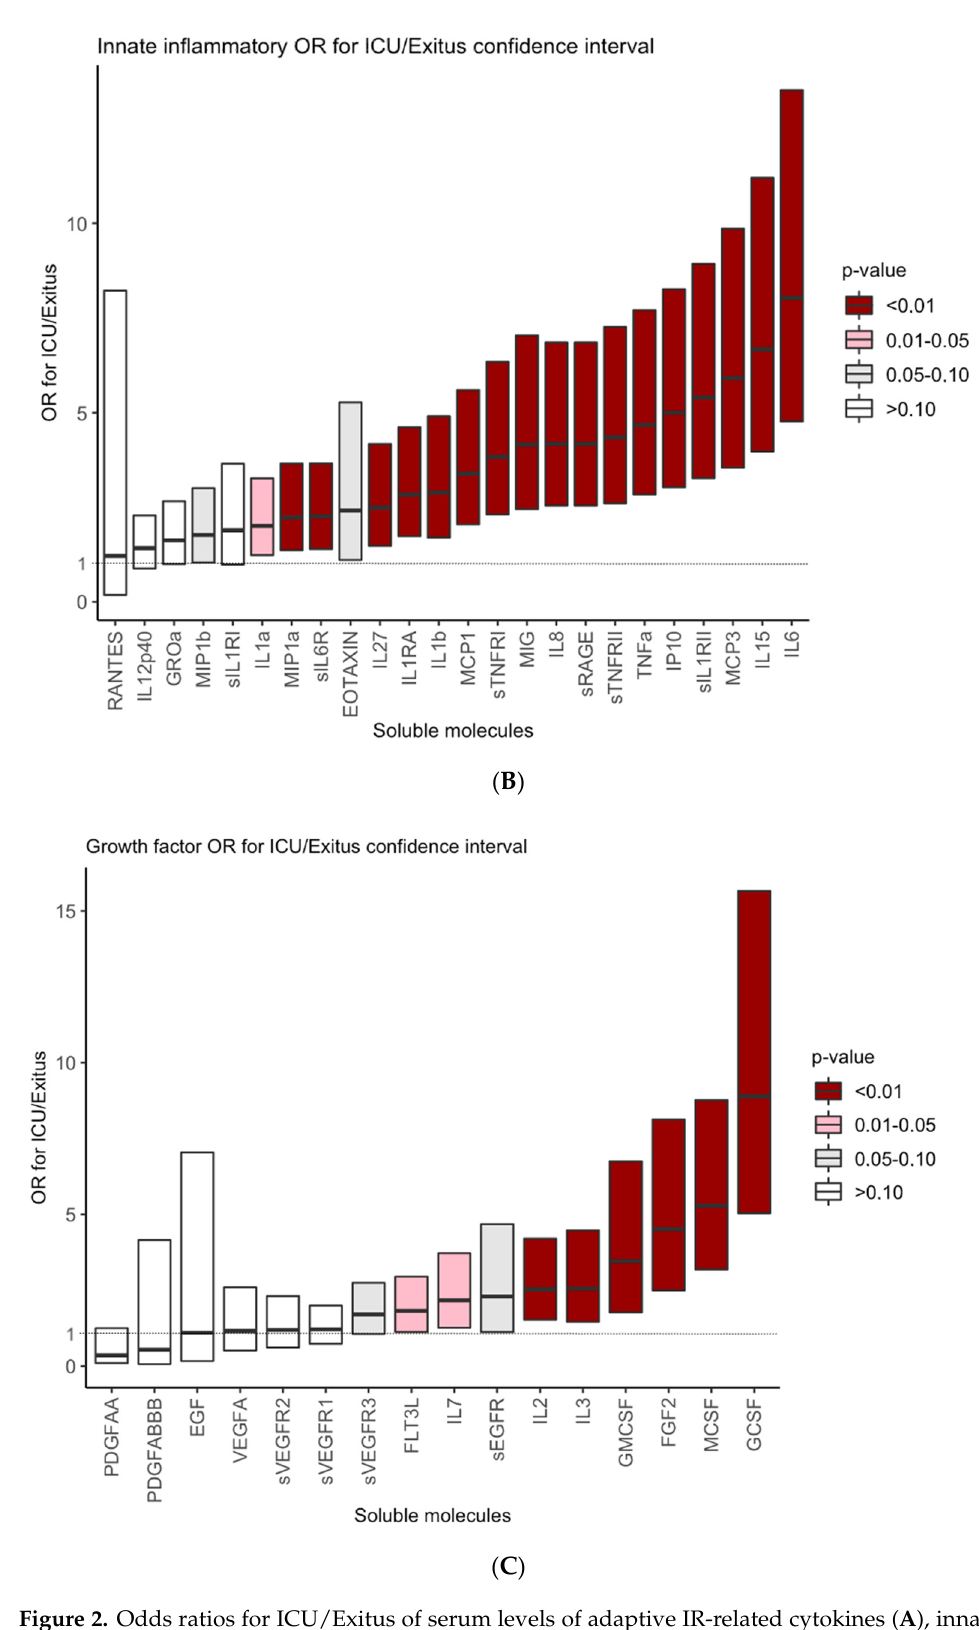
Figure 2. Odds ratios for ICU/Exitus of serum levels of adaptive IR-related cytokines ( A ), innate inflammatory IR-related cytokines ( B ) and growth factors ( C ) in COVID-19 patients. Y axes show the odds ratio of increased concentrations of each marker for ICU/Exitus. The intensity of the color grades the level of the significance of the odds ratio.